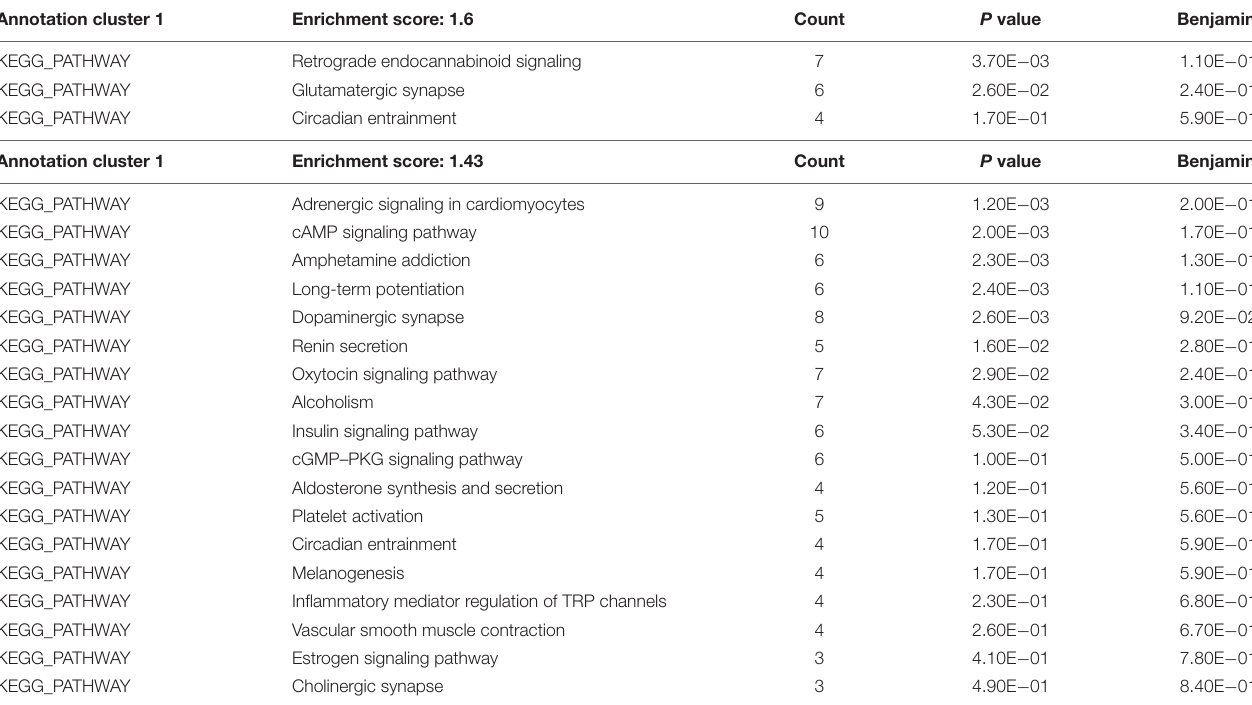
TABLE 2 | KEGG pathway analysis of the target genes of differential expression microRNAs using DAVID bioinformatics resources. Annotation cluster 1 Enrichment score: